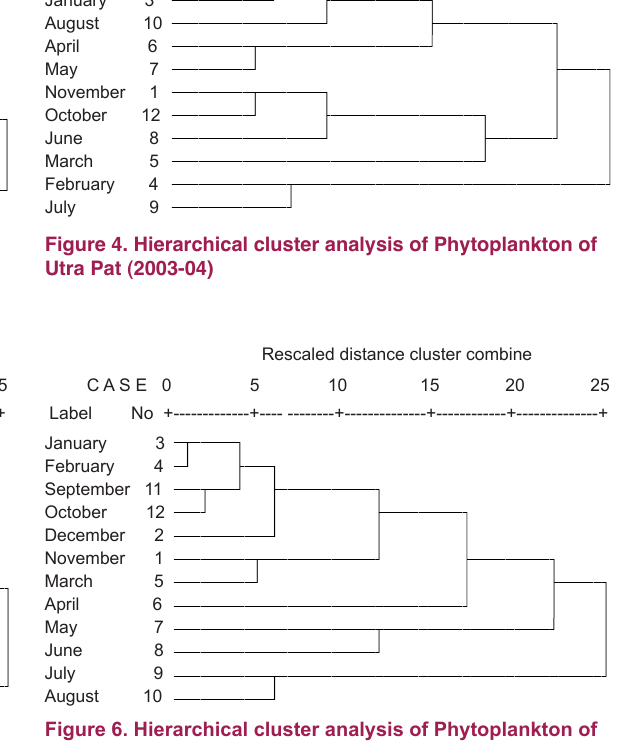
Figure 5. Hierarchical cluster analysis of Phytoplankton of Waithou Pat (2002-03)